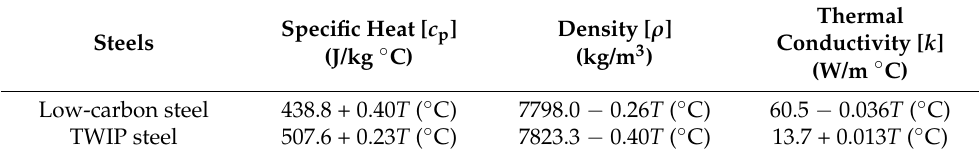
Table 3. Thermal properties of the low-carbon and TWIP steels with temperature.